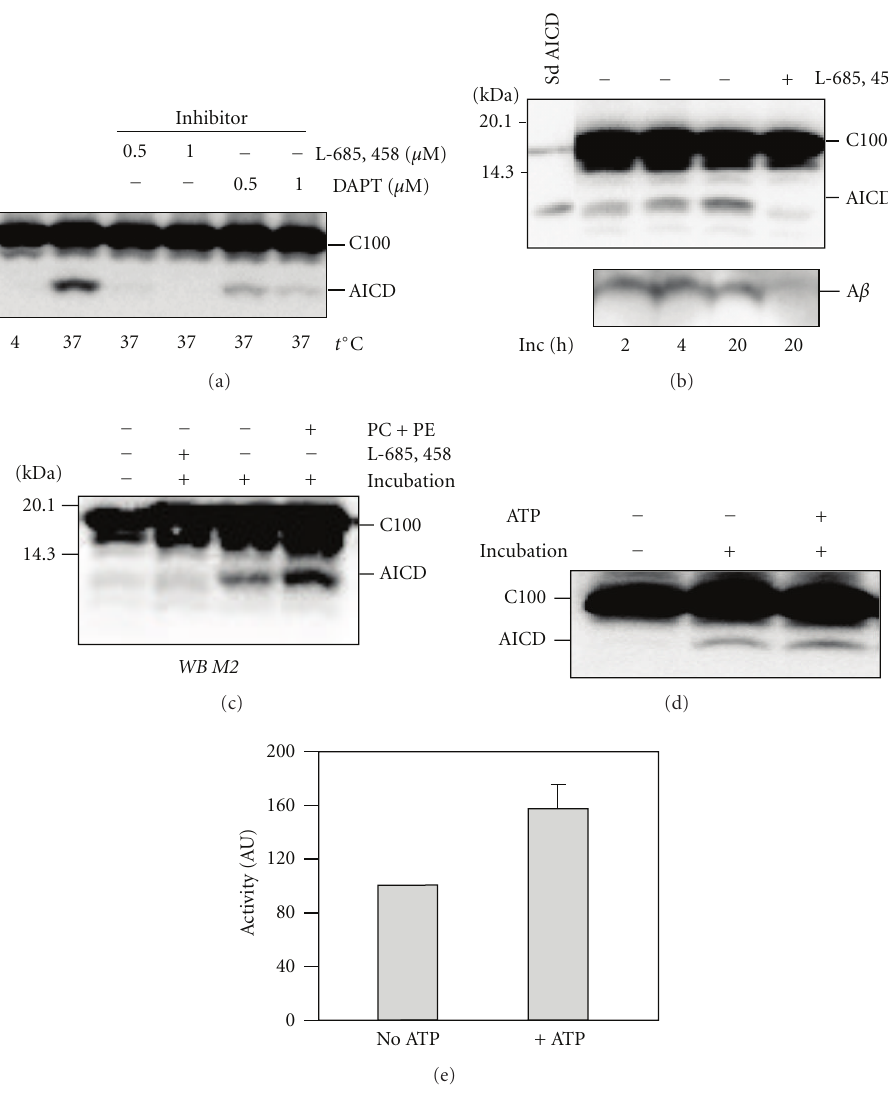
Figure 1: Characterization of γ -secretase in vitro assay with guinea pig brain enzyme. ∼ 1 μ g of purified recombinant C100-3XFLAG was incubated with 2.75 μ g of CHAPSO solubilised membranes of guinea pig brain in 20mM HEPES bu ff er, pH 7.3, plus 3mM CaCl 2 , 3mM MgCl 2 and 150 mM KCl. The reactions were stopped by adding Laemmli bu ff er, boiled, and separated on Tris-Tricine gels. M2 (anti- FLAG) antibody and WO2 (anti-A β 1–16) were used for western blot detection. (a) Production of an AICD fragment in the assay is inhibited by the γ -secretase inhibitors, L-685,458 and DAPT. (b) Both AICD and A β are produced in the reaction and inhibited by L- 685,458. AICD signal increases in a time dependent manner over 20 h. A β signal is increased at 4 h compared to 2h, but decreased at 20h, possibly due to degradation. (Inc, incubation at 37 ◦ C). (c) Positive e ff ect of phospholipids on AICD production in the γ -secretase assay. PC, phosphatidylcholine; PE, phosphatidylethanolamine. (d) Positive e ff ect of ATP on the γ -secretase assay. ATP was added 1.25 mM concentration. (e) Quantitation of three separate experiments using GeneTools Syngene software shows ∼ 1.6 fold enhancement of γ - secretase activity in the presence of 1.25 mM ATP. The error bars represent